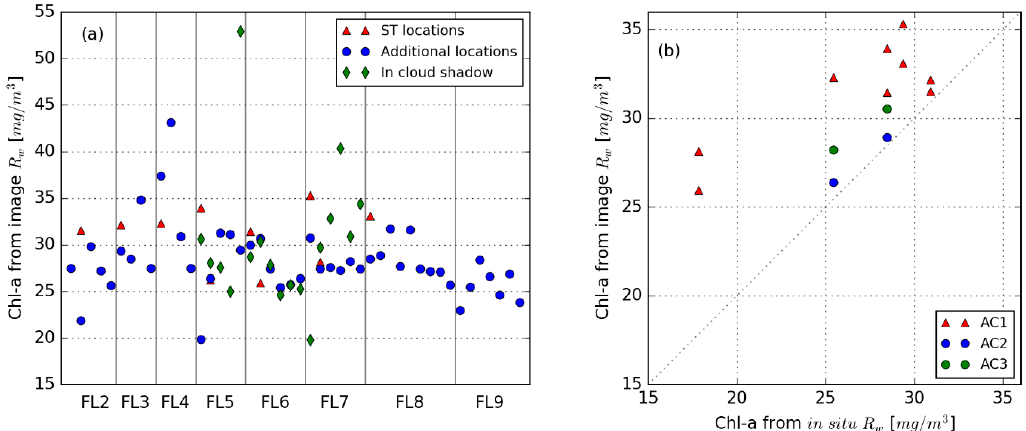
Figure 8. ( a ) Chl-a values in (mg/m 3 ) derived from all measured image R w ; ( b ) scatter plot between Chl-a values derived from in situ R w and image R w at station